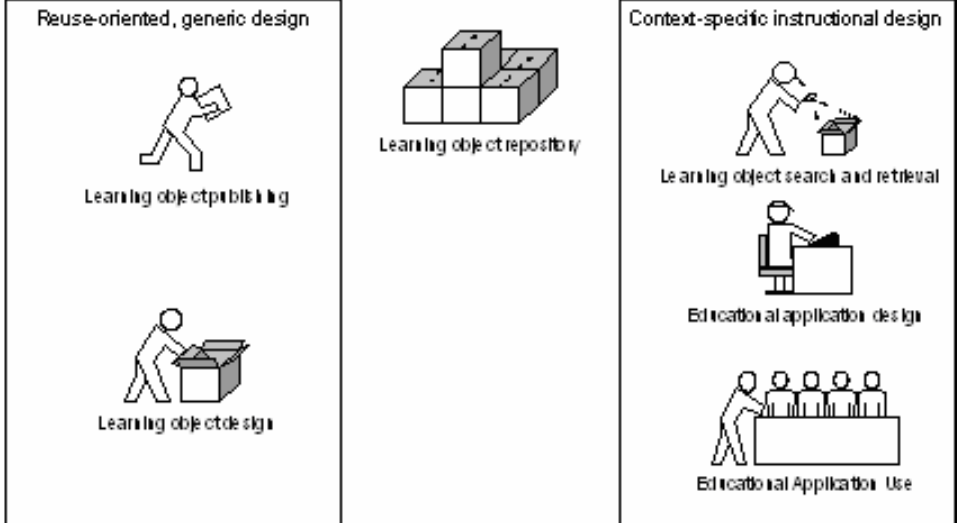
Figure 1. Learning object and educational application design as two differentiated